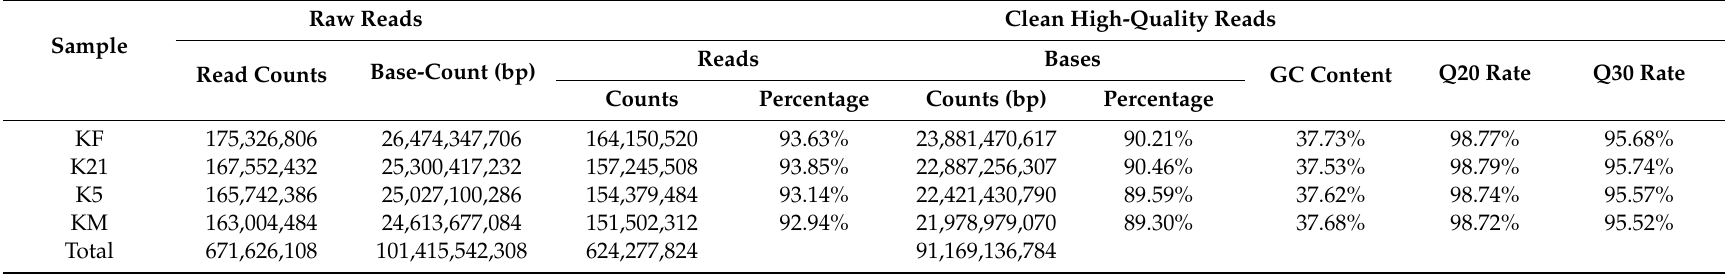
Table 1. Summary of data generated by